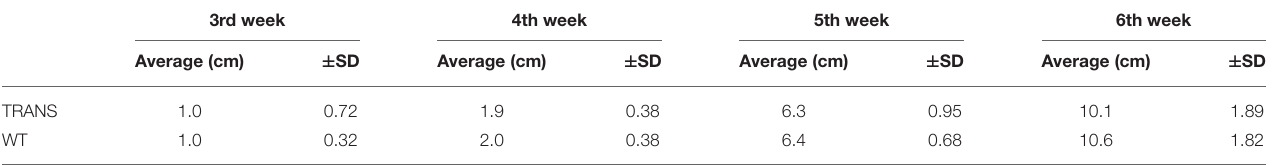
TABLE 2 | Height of transplastomic (TRANS) and wild type (WT) tobacco plants at 3, 4, 5 and 6 weeks after seed